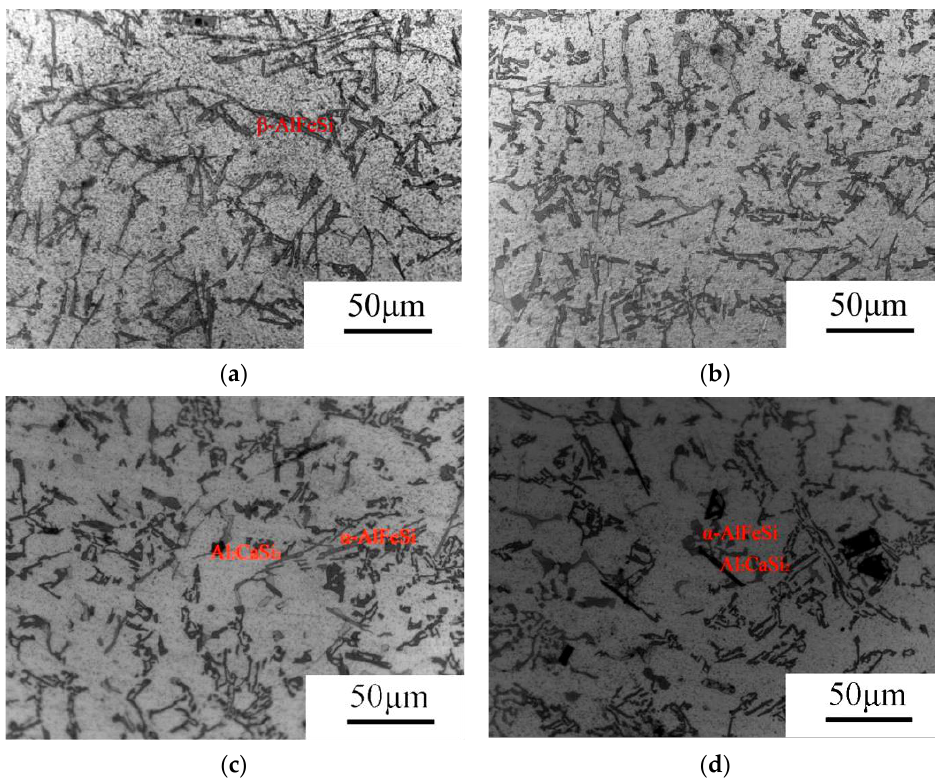
Figure 3. Microstructure of A380 alloy with different Ca additions at 5 °C/s cooling rate: ( a ) 0.01 wt.%; ( b ) 0.05 wt.%; ( c ) 0.1 wt.%; ( d ) 0.3 wt.%.